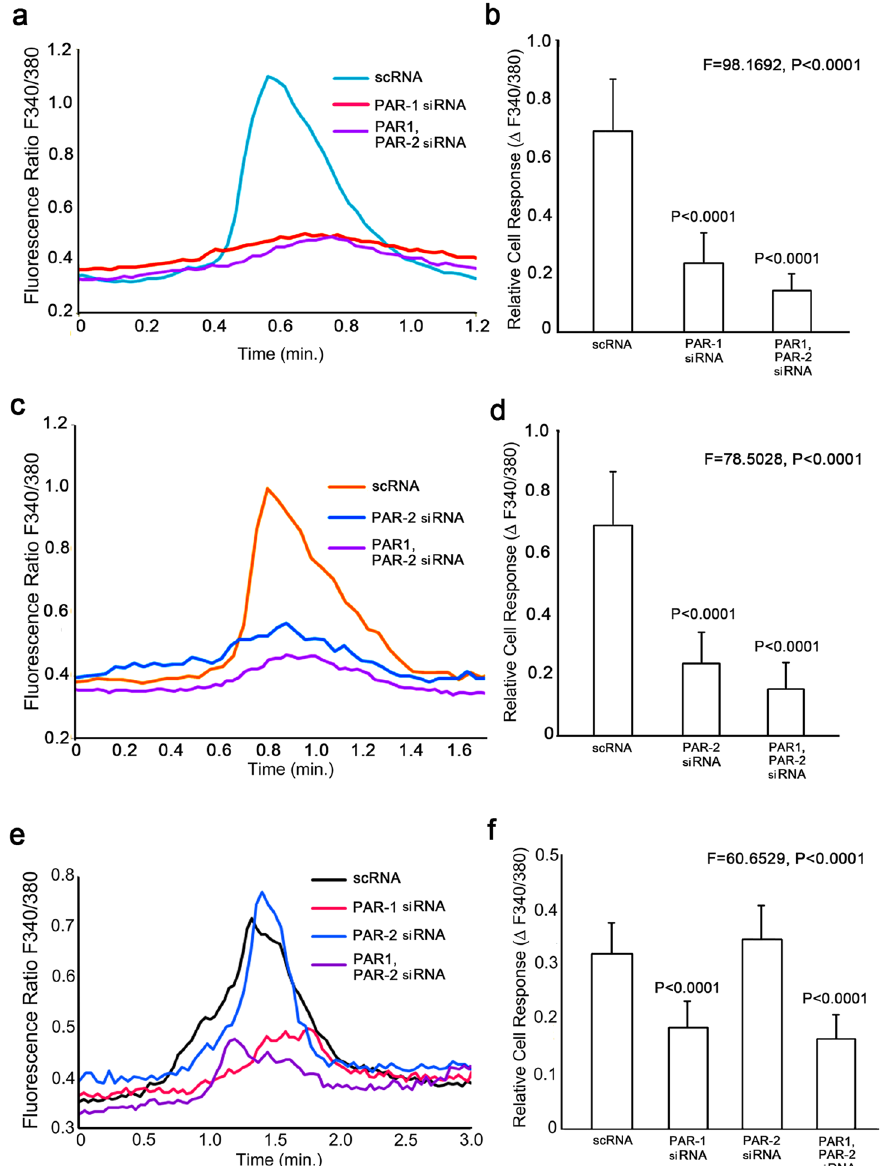
Figure 1. Calcium response induced by PAR-1 agonist, PAR-2 agonist or Cry j1 in PAR-1 and PAR-2 siRNA- treated keratinocytes. ( a ) Application of TFLLR-NH2 (10 μ M) to the scramble RNA-treated cells increased the level of intracellular calcium by approximately 0.69 unit (cyan line), while application of the same amount of TFLLR-NH2 to the PAR-1 siRNA-treated cells (red line) and PAR-1 plus PAR-2 siRNA-treated cells (purple line) increased the level of intracellular calcium by approximately 0.24 unit and 0.14 unit, respectively. ( b ) Quantitation of fluorescence ratio change after application of TFLLR-NH2 to cells treated with scramble RNA, PAR-1 siRNA and PAR-2 siRNA (n = 11–20 cells). Similar results were obtained in three independent experiments. Bars and lines represent mean ± SD. ( c ) Application of SLIGKV-NH2 (10 μ M) to the scramble RNA-treated cells increased the level of intracellular calcium by approximately 0.69 unit (cyan line), while application of the same amount of SLIGKV-NH2 to the PAR-1 siRNA-treated cells (red line) and PAR-1 plus PAR-2 siRNA-treated cells (purple line) increased the level of intracellular calcium by approximately 0.24 unit and 0.15 unit, respectively. ( d ) Quantitation of fluorescence ratio change after application of SLIGKV-NH2 to cells treated with scramble RNA, PAR-1 siRNA and PAR-2 siRNA (n = 11–20 cells). Similar results were obtained in three independent experiments. Bars and lines represent mean ± SD. ( e ) Application of Cry j1 (100 ng/ml) to the scramble RNA-treated cells increased the level of intracellular calcium by approximately 0.32 unit (black line), while application of the same amount of Cry j1 to the PAR-1 siRNA-treated cells (red line) and PAR-1 plus PAR-2 siRNA-treated cells (purple line) increased the level of intracellular calcium by approximately 0.18 unit and 0.16 unit, respectively. Application of the same amount of Cry j1 to the PAR-2 siRNA-treated cells increased the level of intracellular calcium by approximately 0.34 unit (blue line). ( f ), Quantitation of fluorescence ratio change after application of Cry j1 to cells treated with scramble RNA, PAR-1 siRNA and PAR-2 siRNA (n = 20 cells). Similar results were obtained in three independent experiments. Bars and lines represent mean ±